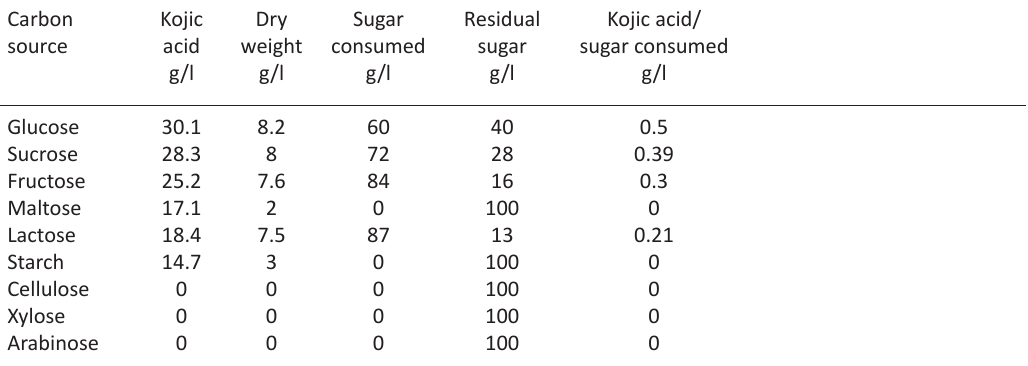
Table 5. Effect of various carbon source on synthesis of kojic acid, drymass and consumption of sugar by A. flavus Carbon Kojic Dry Sugar Residual Kojic acid/